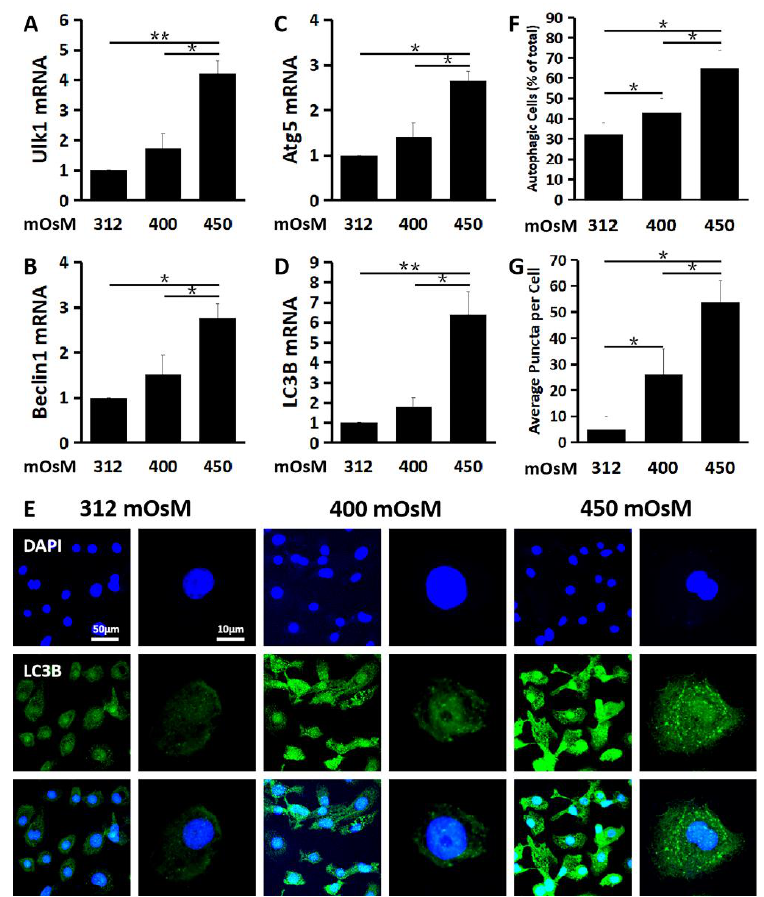
Figure 2. Hyperosmolarity induced autophagosome formation in primary HCECs. The mRNA expression of Ulk1 ( A ), Beclin1 ( B ), Atg5 ( C ) and LC3B ( D ) was significantly induced in HCECs exposed to hyperosmolar medium at 450 mOsM for 24 h, as evaluated by RT-qPCR. ( E ) Representative immunofluorescent images showing the LC3B positive cells with punctate staining in HCECs at various osmotic conditions. ( F ) Percentage of LC3B positive autophagic cells in HCECs at different osmolarities, evaluated by randomly selected fields with at least 100 cells per sample. ( G ) Average puncta per autophagic cell. The data are presented as mean ± SD from three independent experiments. * p < 0.05, ** p < 0.01, compared between two groups.